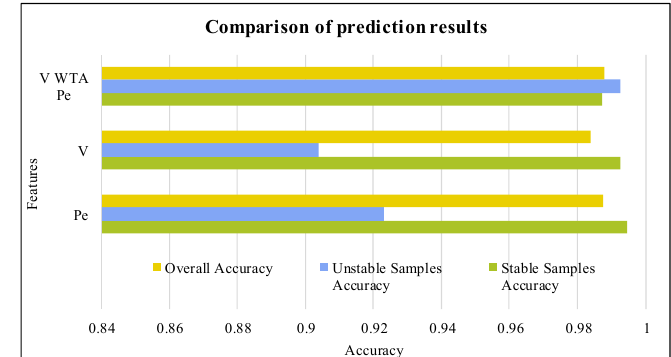
Figure 13. Comparison of accuracy in different models.